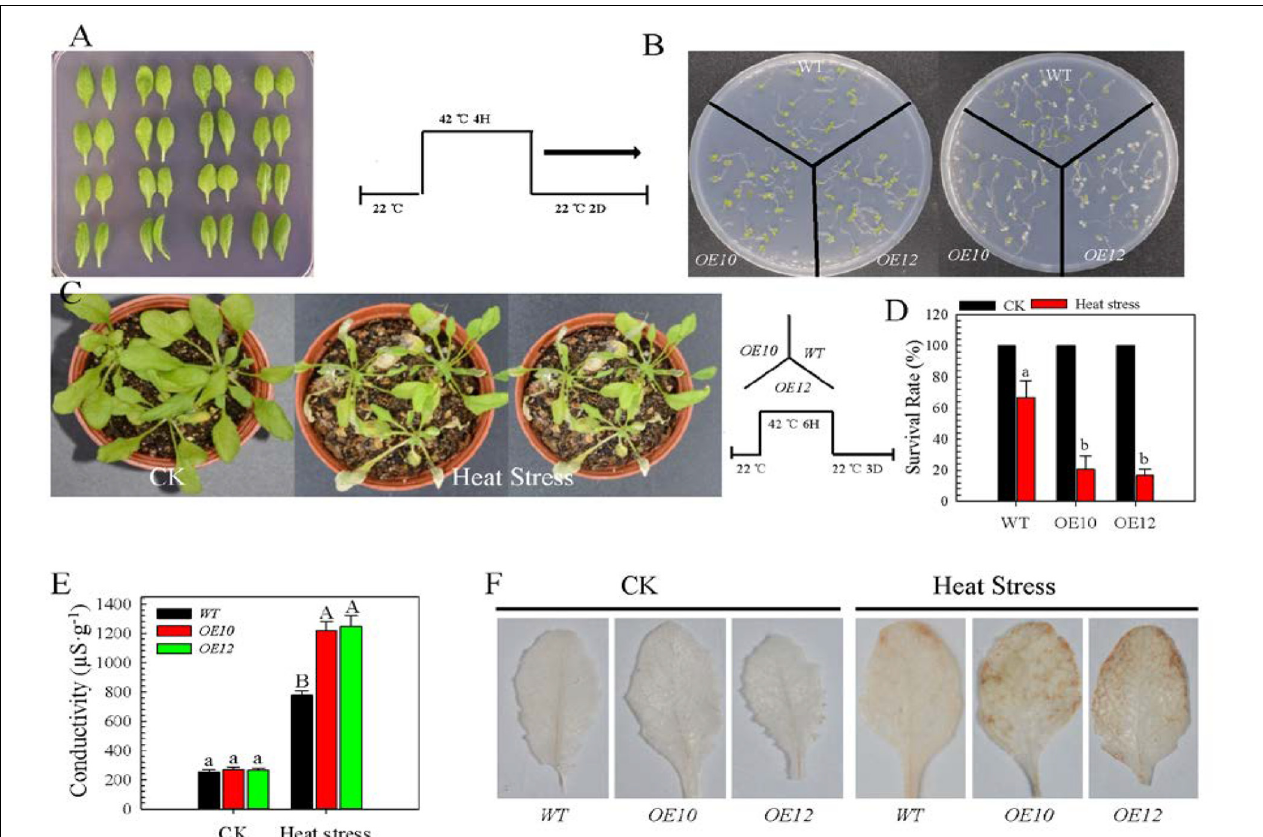
FIGURE 3 | Overexpression of CaWRKY27 reduced basal thermotolerance in transgenic Arabidopsis plants. (A) Leaves of CaWRKY27- overexpressing Arabidopsis and WT plants that were grown in pots for 5 weeks under normal conditions. (B) Phenotypes of CaWRKY27-OE10 , OE12 , and WT seedling that were treated at 37 ◦ C for 4 h and then returned to 22 ◦ C for 2 days of recovery. (C) Phenotypes of 35-day-old CaWRKY27-OE10 , OE12 , and WT plants that were treated at 37 ◦ C for 6 h and then returned to 22 ◦ C for 3 days of recovery. (D) Survival rate were analyzed in CaWRKY27-OE10 , OE12 , and WT plant after 3 days recovery following heat treatment at 37 ◦ C for 6 h. Data represent the mean ± SE ( n = 3), each replicate consists of eight plants. (E) Electrolyte leakage in 28-day-old heat-treated seedlings was monitored by measuring conductivity. (F) H 2 O 2 accumulation in leaves from heat-treated (37 ◦ C) WT, CaWRKY27-OE10 , and OE12 plants was measured by DAB staining. Data represent the mean ± SE of three biological replicates. Different letters indicate significant differences compared to WT ( SNK -test, lowercase letters indicate P < 0.05, and uppercase letters indicate P < 0.01).